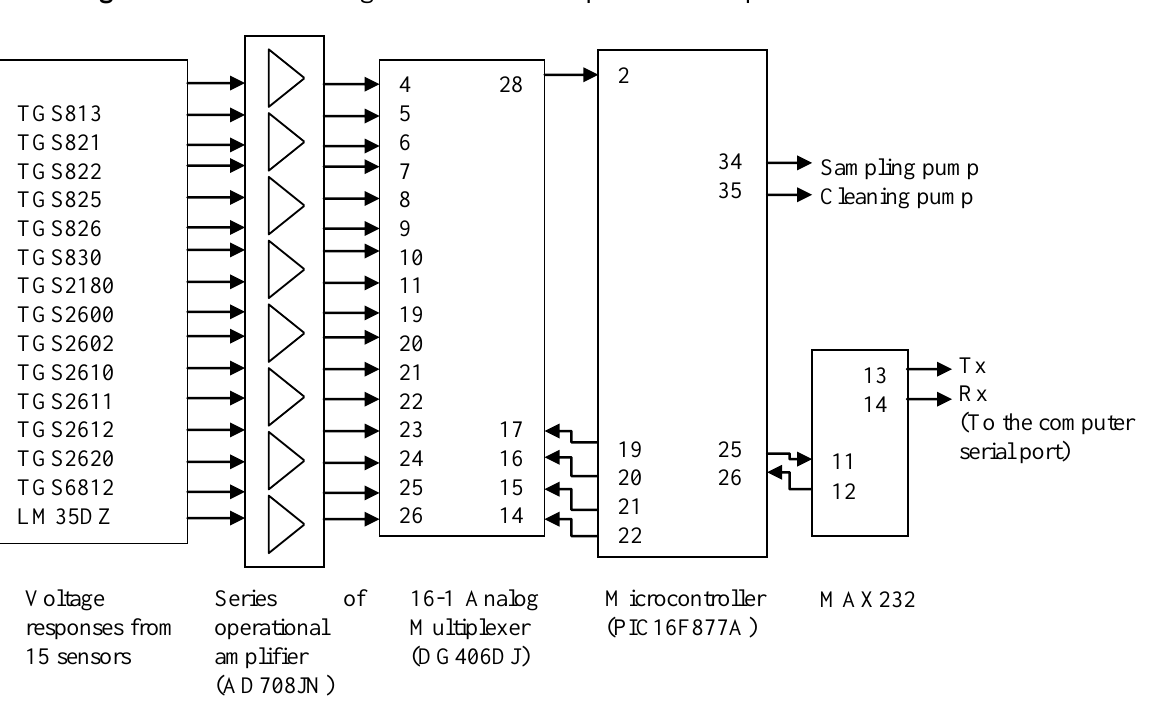
Figure 5. The block diagram of the developed Data Acquisition and Controller Unit.